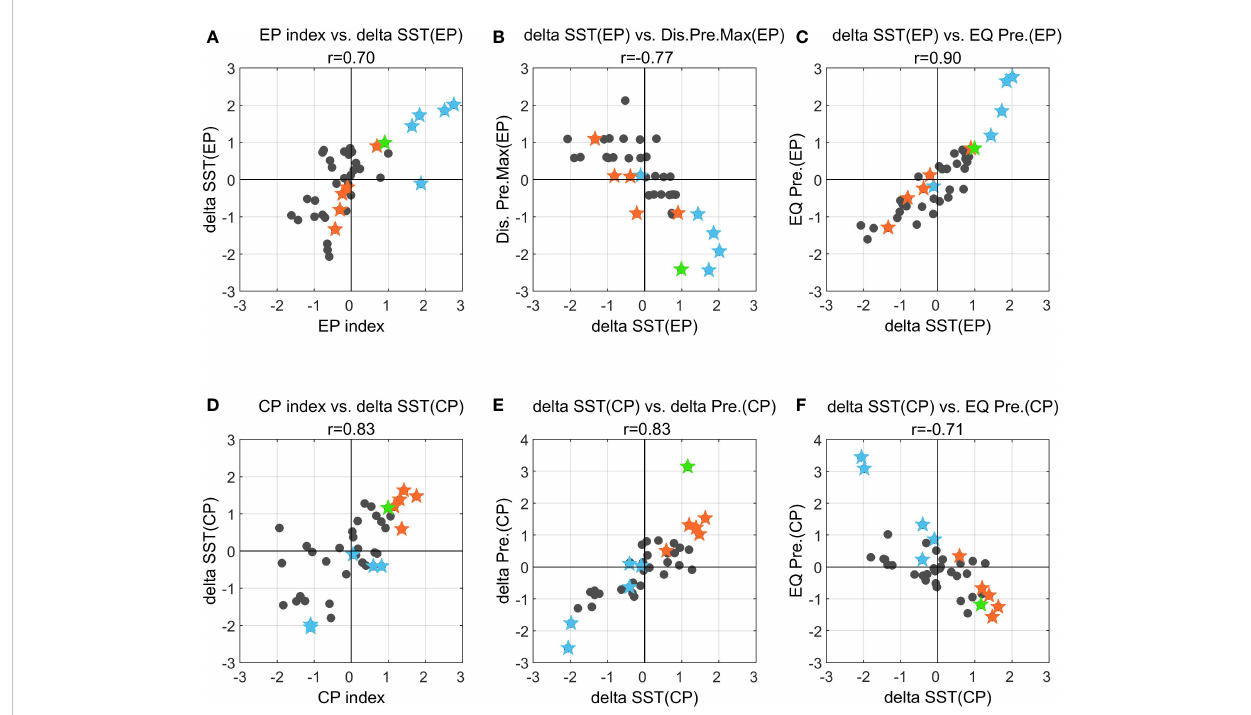
FIGURE 7 (A) EP index versus EP-type delta SST; (B) EP-type delta SST versus change in distance between two ITCZs; (C) EP-type delta SST versus EP-type equatorial precipitation; (D) CP index versus CP-type delta SST; (E) CP-type delta SST versus delta precipitation; (F) CP-type delta SST versus CP- type equatorial precipitation. For each sub fi gure, solid stars denote the El Niño decaying years: EP-type (blue), CP-type (orange) and the 2009/2010 mixed-type (green). All these indices are calculated for March-April and are normalized. In all sub fi gures, the correlations pass con fi dence test at a 99% con fi dence